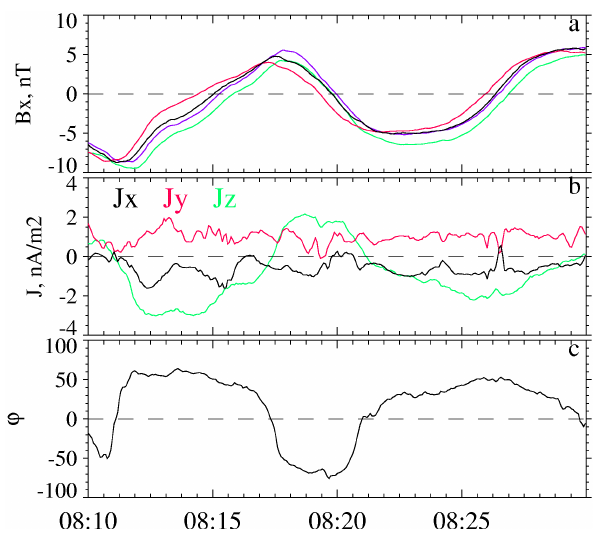
Fig. 6. Three crossings from the 3 August 2004 event in the format of Fig. 4. (a) B x magnetic field, (b) Components of current density, (c) φ , tilt of the normal in the Y-Z plane.